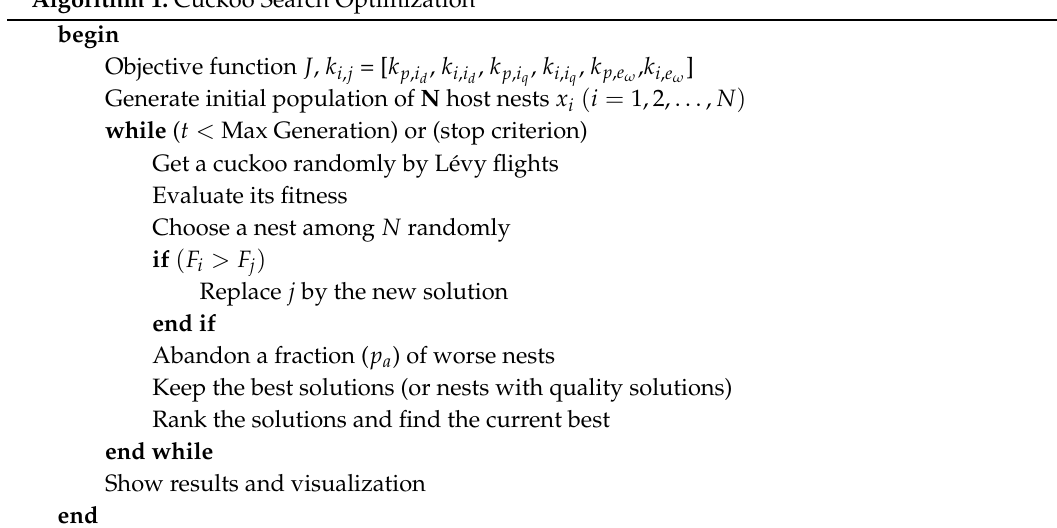
Algorithm 1: Cuckoo Search